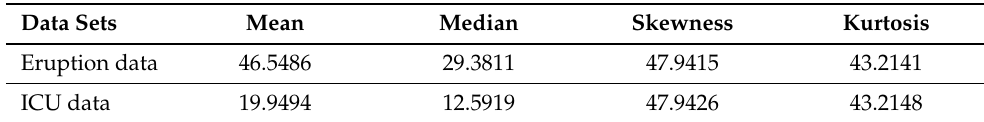
Table 3. Descriptive measures for the two data sets. Data